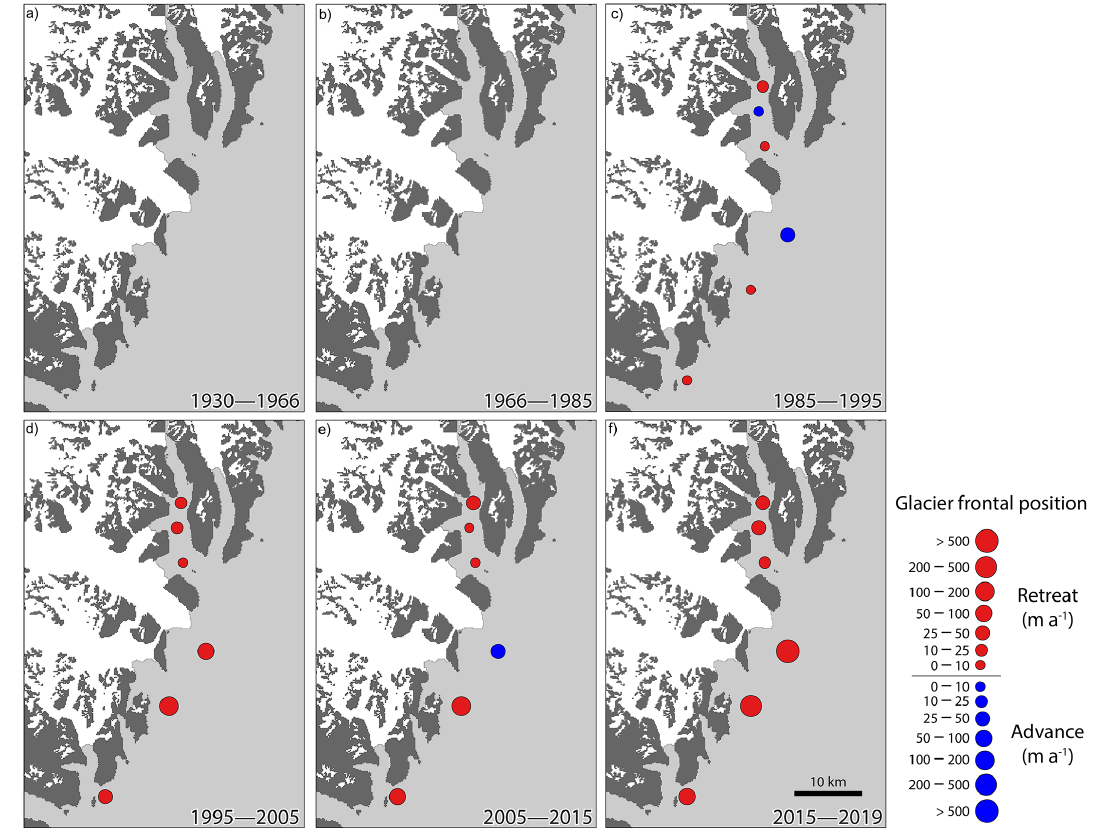
Figure 5. Graphical representation of annual rate of change in frontal position of glaciers in the southern region. Panels (a) to (f) show annual rates of change over the different time-steps that we have been able to generate from our various image sources. (a) BAARE mission (1930) to CORONA mission (1966). (b) CORONA mission (1966) to Landsat 5 (1985). (c) Landsat 5 (1985) to Landsat 5 (1995). (d) Landsat 5 (1995) to Landsat 7 (2005). (e) Landsat 7 (2005) to Landsat 8 (2015). (f) Landsat 8 (2015) to Landsat 8 (2019). Red circles represent retreat and green circles represent advance. Circles are sized proportionally to the magnitude of change. Note the lack of measurements in the first two periods. This arises because we do not have data for the 1960s for this region. As with the northern region, larger magnitude glacier retreat rates dominate in the most recent period